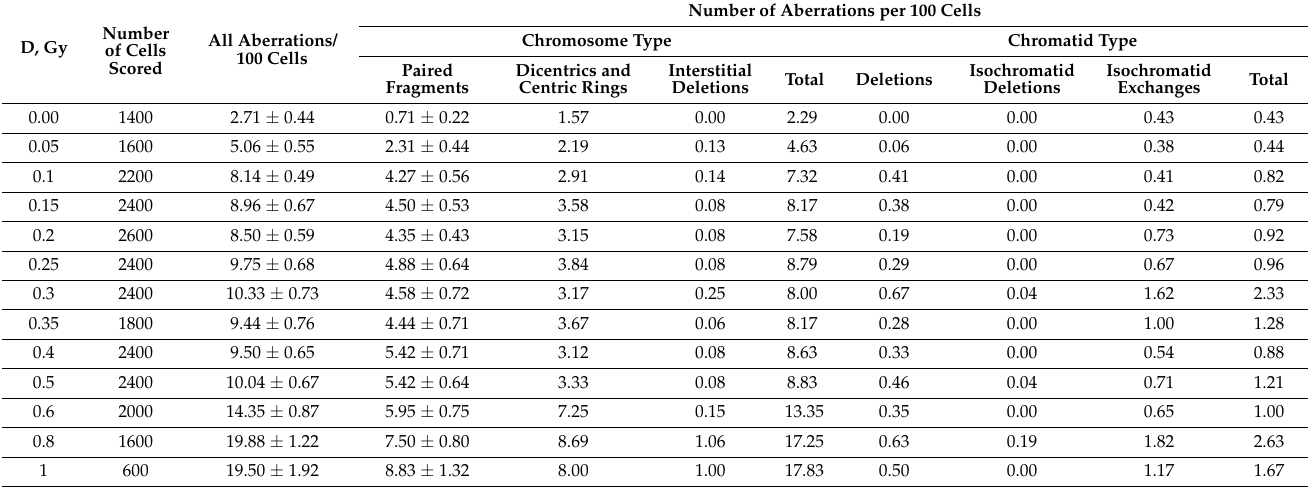
Table A2. Frequencies of chromosome aberrations induced in CHO-K1 cells by low doses of 83 MeV protons.